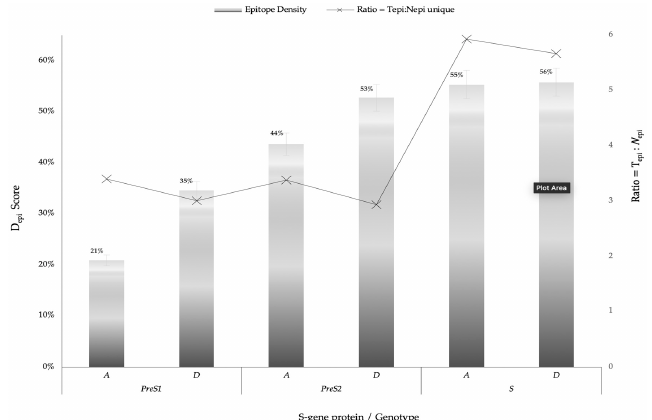
Figure 2. Epitope densities (D epi ) of different PreS/S proteins stratified by genotype (A or D) and protein ( PreS1 , PreS2 , S ). D (cid:2915)(cid:2926)(cid:2919) (cid:3404) (cid:80) n i = 1 I epi where i can be any protein (PreS / S A versus PreS / S D ). T epi X Protein length PreS1 A represent genotype A large Hepatitis B surface antigen (HBsAg); PreS1 D represent genotype D large HBsAg; PreS2 A represent genotype A middle HBsAg; PreS2 D represent genotype D middle HBsAg; S A represent genotype A small HBsAg; S D represent genotype D small HBsAg. T epi = Total binding peptides (WB + SB). N epi unique = count of unique binding peptides per each